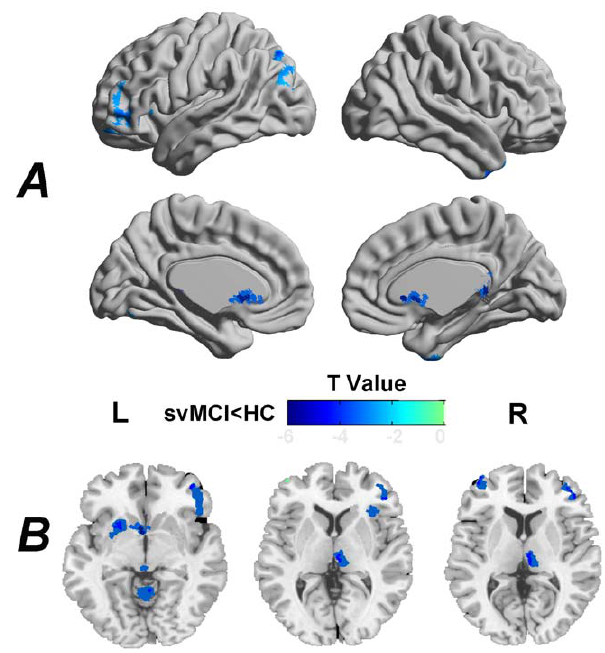
Figure 1. Cortical (A) and subcortical (B) GM volume loss in svMCI. The svMCI patients showed decreased GM volume in several frontal, temporal, occipital and subcortical brain regions. For the details, see Table 2. The statistical threshold was set at P , 0.01 for individual voxels and cluster size . 948 mm 3 , which corresponded to a corrected P , 0.01 determined by Monte Carlo simulations. Cortical (A) t statistical maps were rendered by using the BrainNet Viewer (http://www.nitrc. org/projects/bnv/). Subcortical (B) t statistical map was overlaid on a single anatomical image (i.e., ch2bet.nii) provided in the MRIcroN software (http://www.cabiatl.com/mricro/). R, right; L, left.